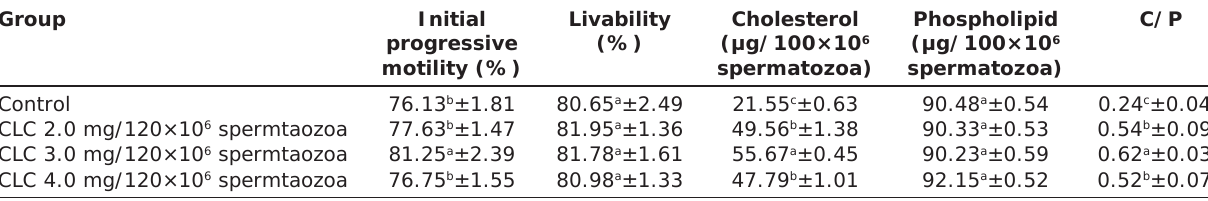
a, b, C Means with dissimilar superscript in a column differ significantly (p<0.01). SE=Standard error Table-2: Seminal attributes in Buffalo bulls spermatozoa at post-thaw stage (mean±SE). Group